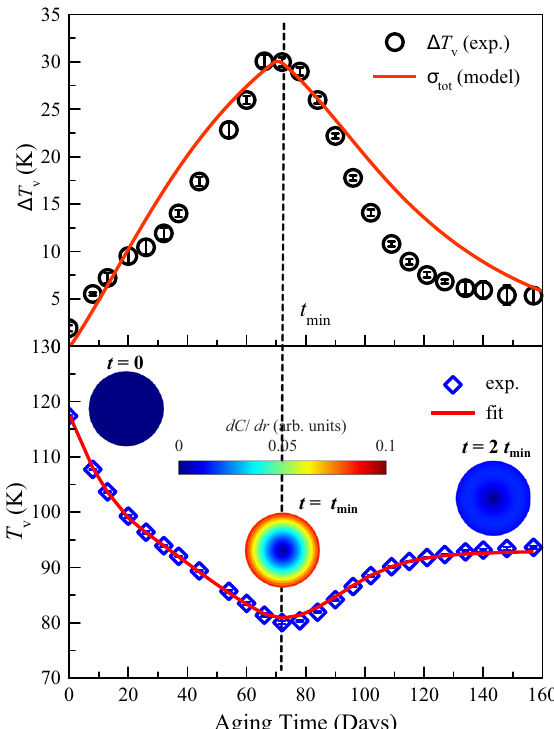
Fig. 4 Model fi ts to the Verwey transition temperature and width. a The aging time dependence of Δ T V is de fi ned as the FWHM of the peak in the fi rst derivative of the magnetization ( dM / dT ). The red line represents the calculated total strain σ tot (see “ Methods ” ). The absolute value of σ tot is scaled to match Δ T V . The error bars for Δ T V is de fi ned as the SD of the fi tted FWHM of the peak in dM / dT . b Time variation of T V from magnetization points in Fig. 3a, fi tted by the model curve as described in “ Methods. ” Drawings show the oxygen concentration gradient dC / dr in magnetite nanoparticles at 0, 70, and 140 days of aging time, calculated for D = 10 − 19 cm 2 /s, a = 20 nm, and t = 70 days using the boundary min conditions described in “ Methods. ” The error bars for T V is de fi ned as the SD of the center position based on the fi tting of the peak in dM / dT .